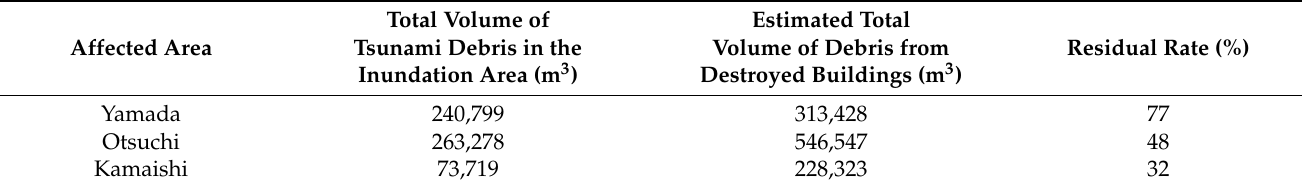
Table 1. Volume of residual accumulated debris; estimated debris volume from washed away and totally destroyed buildings; its residual rate.